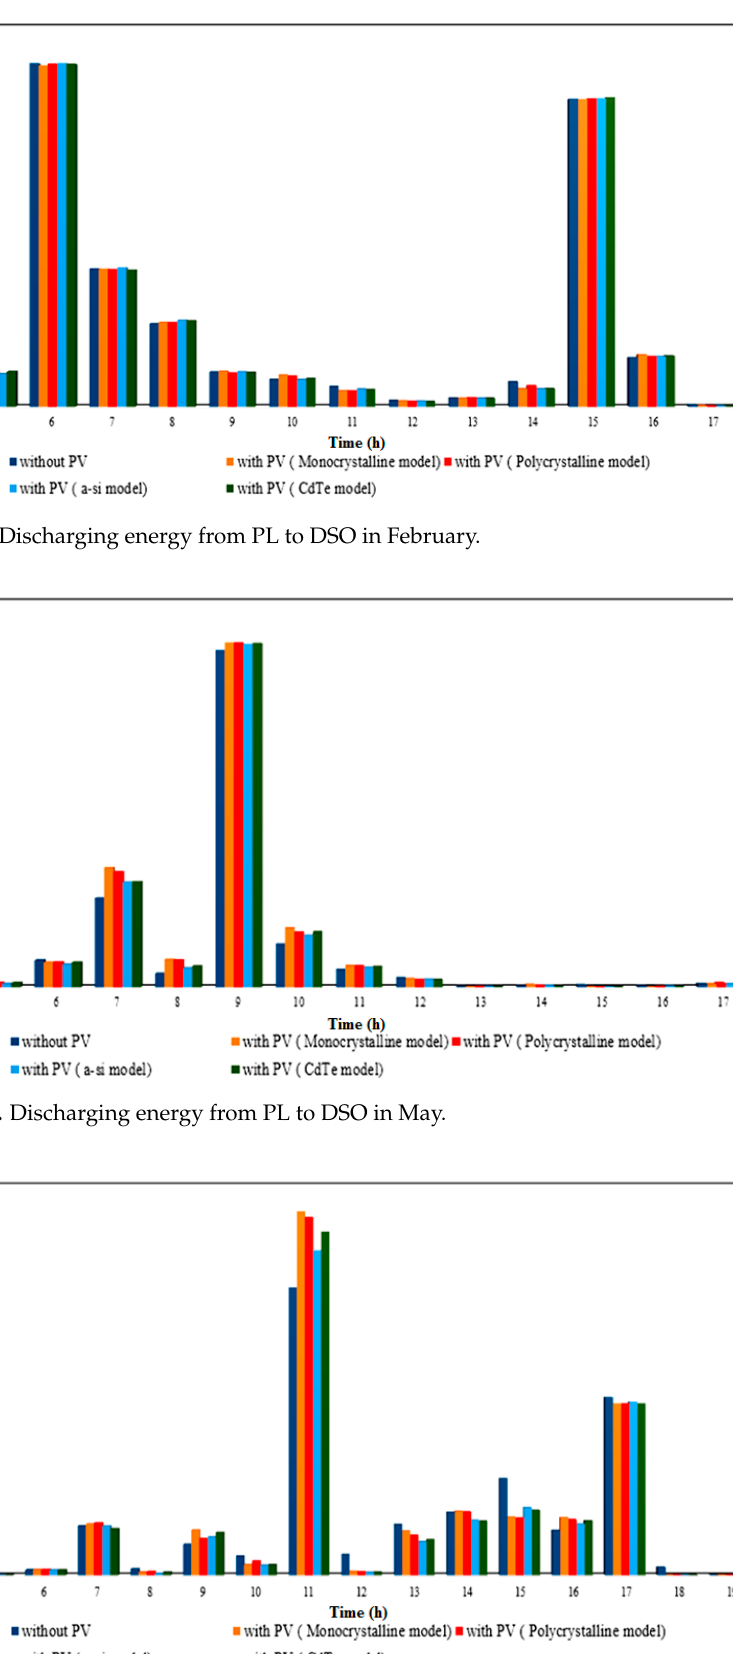
Figure 12. Discharging energy from PL to DSO in November. As it can be seen, installing PV rooftops on EV parking lots reduces the energy pur- chased from DSO to PL but the performance of the PV technology can change the amount of energy exchanged. Table 7 presents the profit of the parking lot operator in all scenarios. Based on the results, the least profitable scenario is scenario I because all the required energy is supplied by DSO due to the lack of other energy sources to support the EV charging energy. Thus the parking lot operator gains less profit. Table 7. PLO’s profit (€) by using different PV technologies. PV Technology/Month